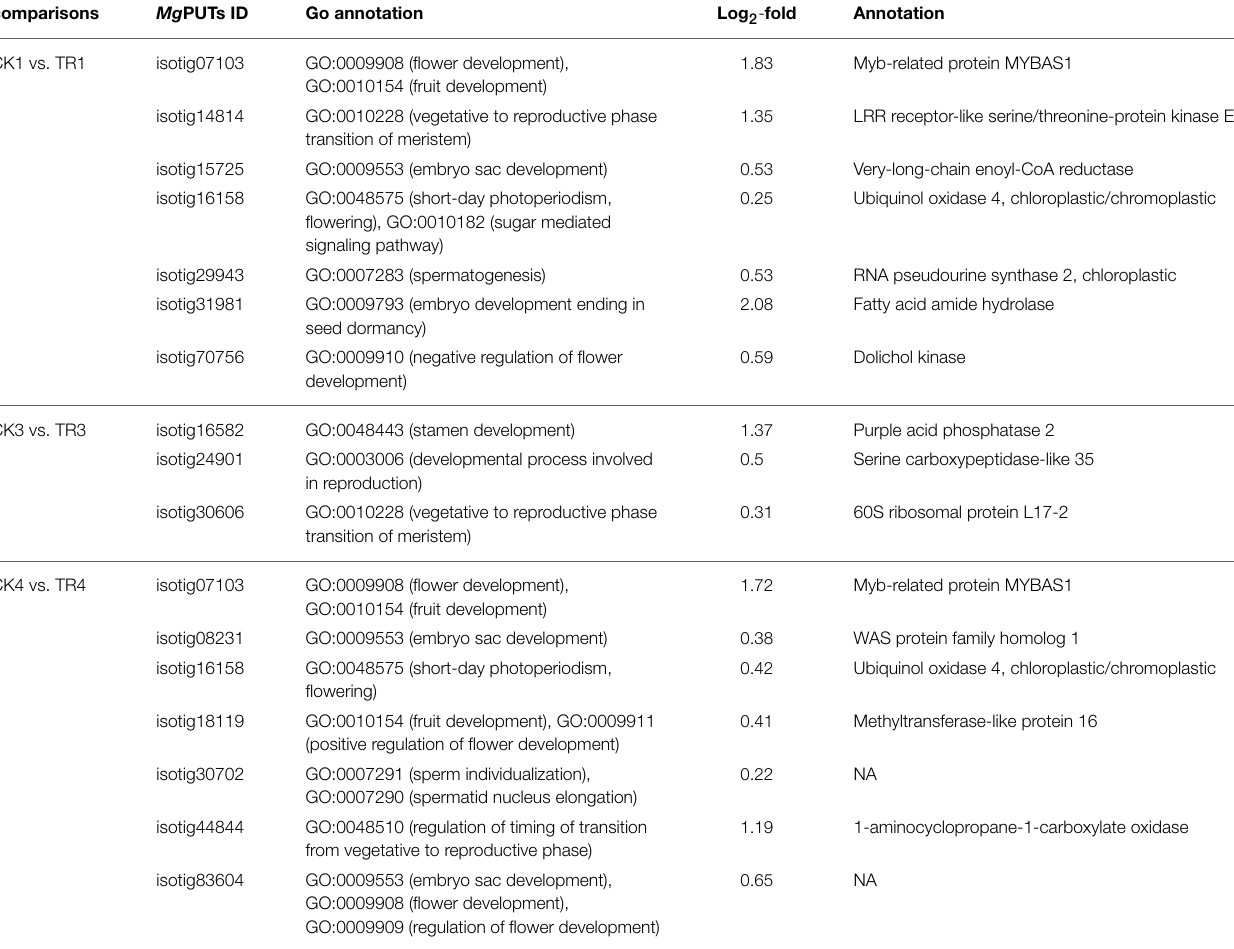
TABLE 4 | Upregulated genes in hormone-treated shoots with annotations in the vegetative to reproductive phase transition and flowering development.